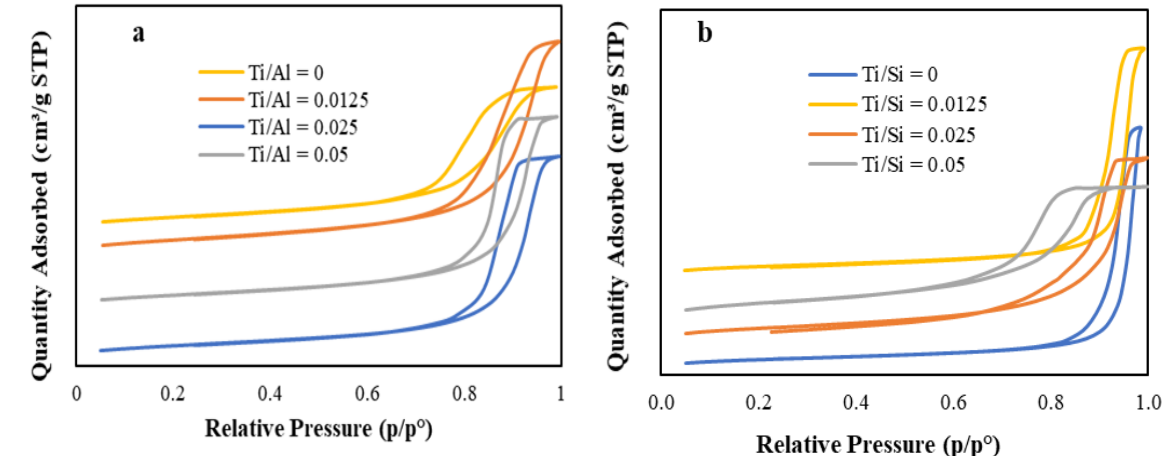
6 Figure 2. XRD spectra of ( a ) HPMo/Ti-Al 2 O 3 and ( b ) HPMo/Ti-TUD-1 catalysts. The nitrogen adsorption-desorption isotherms of HPMo/Ti-Al 2 O 3 and HPMo/ Ti- TUD-1 catalysts are shown in Figure 3. Both types of catalysts show the Type IV isotherm